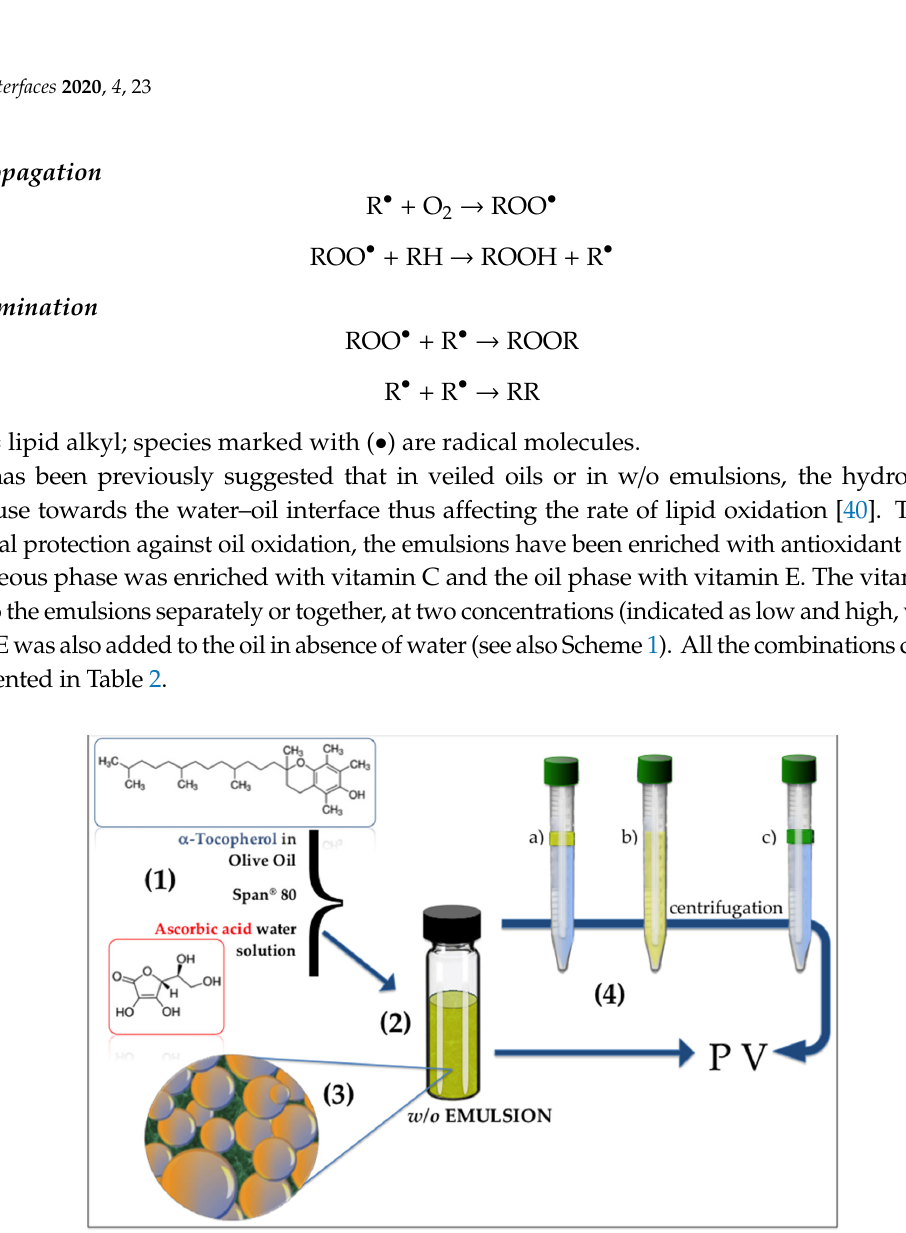
Figure 2. PV as a function of time in: E, w/o emulsion; E-C(L) w/o emulsion enriched with low concentration of vitamin C; E-C(H) w/o emulsion enriched with high concentration of vitamin C; O, oil (bars represent standard deviation of mean values).